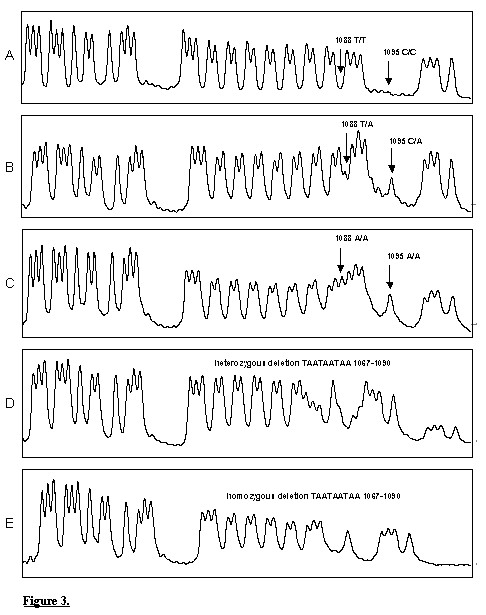
NAT1 alleles in 3'-untranslated region assessed by single A-track sequencing on Alf Express™. Displayed area from A1038 to A1104. (A) NAT1*4/*4 – wild type; (B) 1088T/A and 1095C/A heterozygote; (C) 1088A/A and 1095A/A homozygote; (D) NAT1*4/*11 allele; (E) NAT1*11/*11 allele.